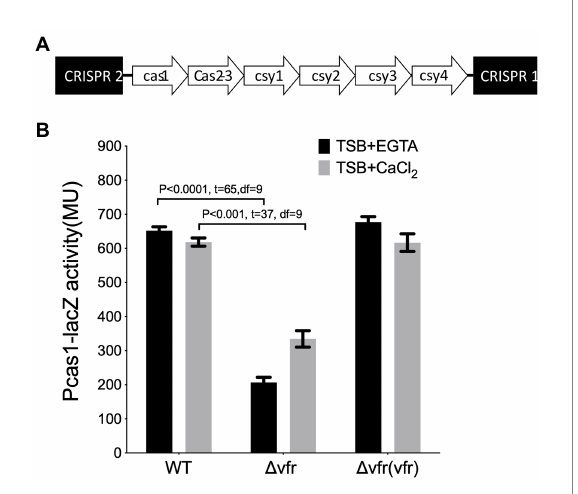
FIGURE 1 Identification of Vfr as a regulator of Type 1F CRISPR-Cas system (A) . Organization of the type I-F CRISPR-Cas system in Pseudomonas aeruginosa UCBPP-PA14 (B) . The β galactosidase assay showing the expression of cas1 in the wild-type PA14, and vfr in-frame deletion mutants, and the vfr complement , Δ vfr (vfr) , grown in calcium-deplete (TSB + CaCl 2 ) and calcium-rich (TSB + CaCl 2 ) media. Data represent mean ± SD from three independent repeats. Statistical analysis was conducted by student’s t -test with a p value of <0.05 is considered